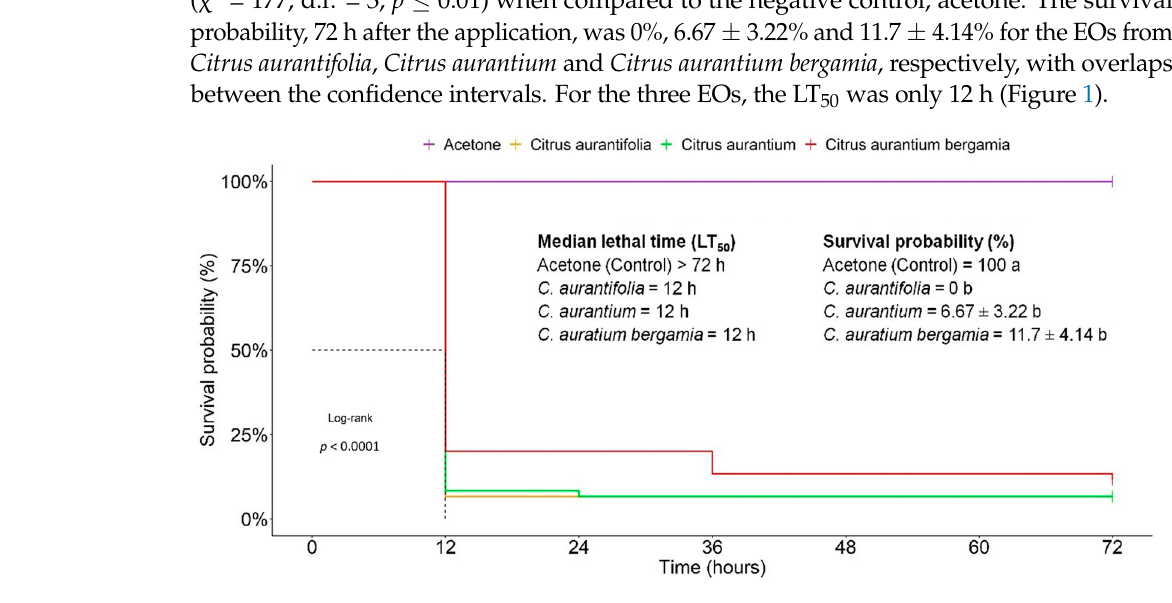
Figure 1. Survival curves, estimated by the Kaplan–Meier method, of Tuta absoluta 2° instar larvae over time submitted to topical application with essential oils from Citrus aurantifolia , Citrus aurantium and Citrus aurantium bergamia .